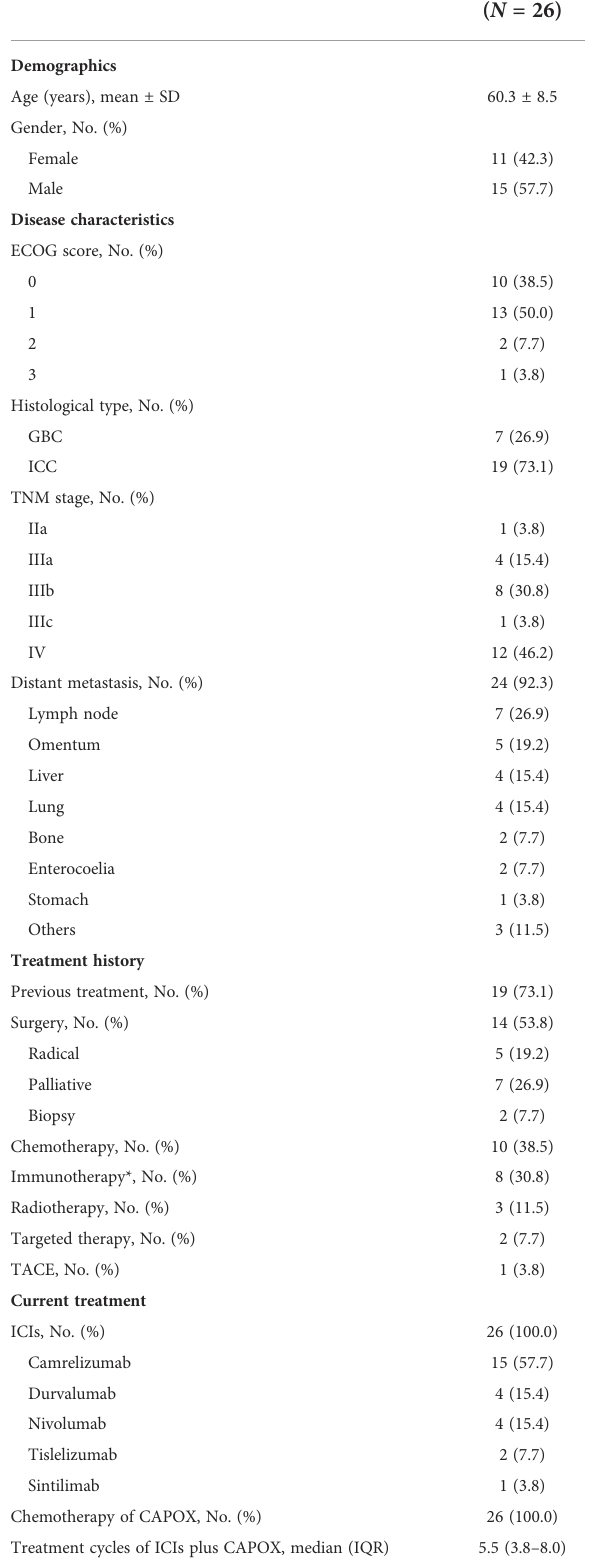
TABLE 1 Clinical